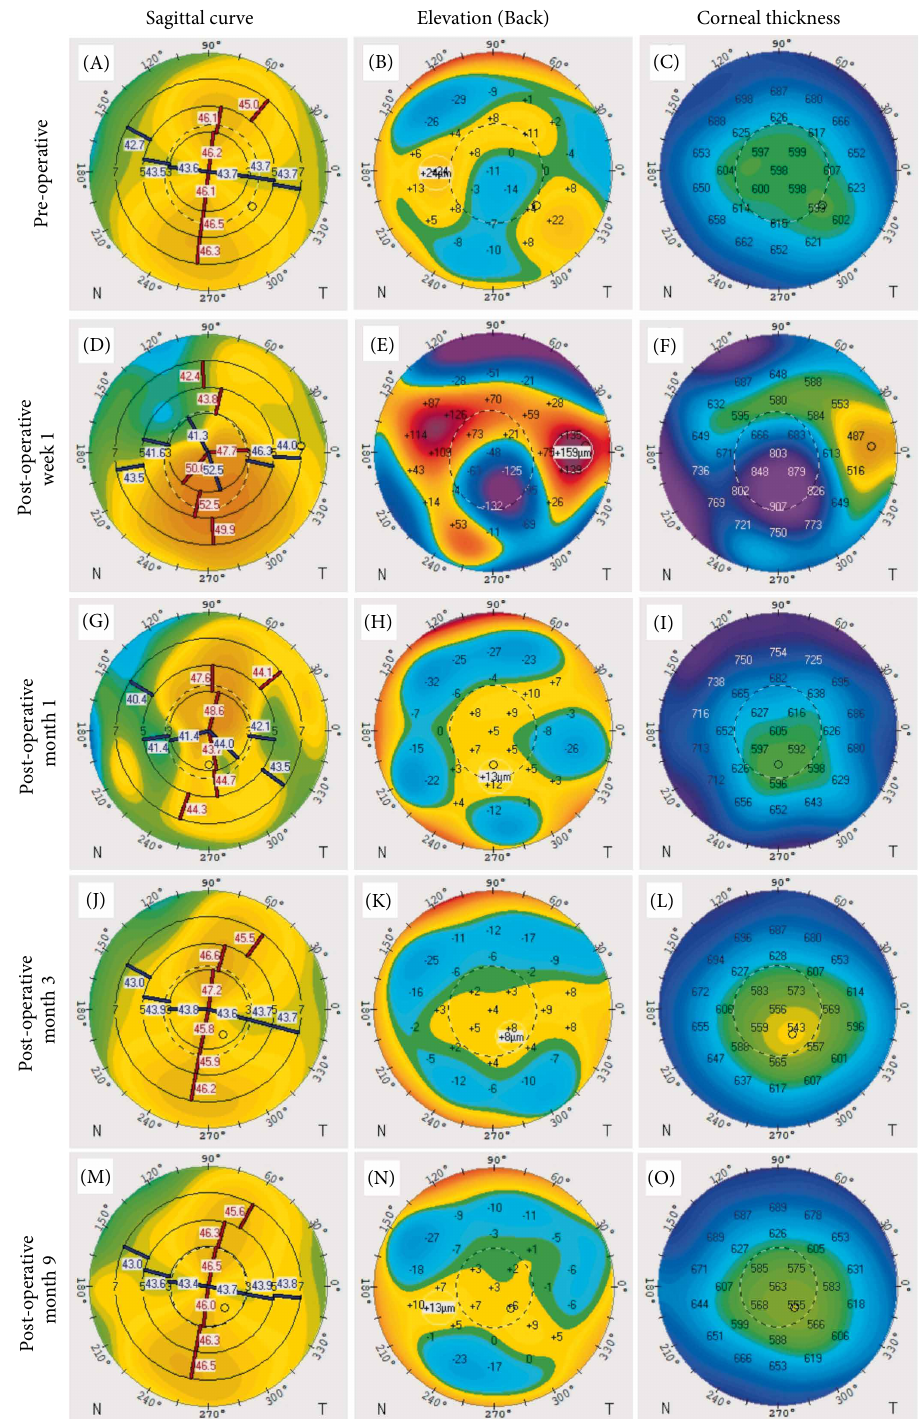
Figure 3: Sagittal corneal curvature, back surface elevation, and pachymetry maps pre- and post-DSO for the left